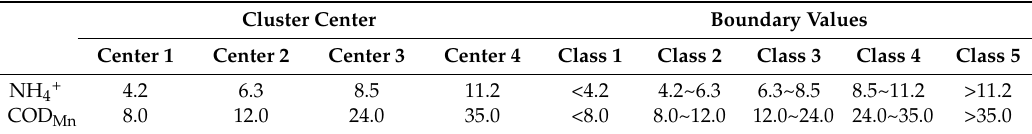
Table 6. Classes of water quality for NH 4+ and COD Mn.